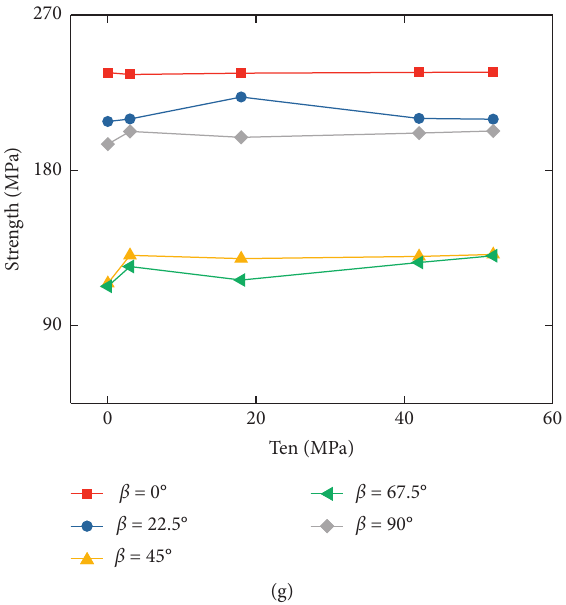
Figure 10: The cumulative distribution curve and average fragment size of layered rocks with different bedding tensile strength. (a–e) The distribution curve of 0 ° , 22.5 ° , 45 ° , 67.5 ° , and 90 ° samples, red: ten � 0.01 MPa, blue: ten � 3MPa, yellow: ten � 18MPa, green: ten � 42MPa, and gray: ten � 52 MPa. (f) Average fragment size vs. bedding tension strength under different bedding angles. (g) Dynamic strength vs. bedding tension strength under different bedding